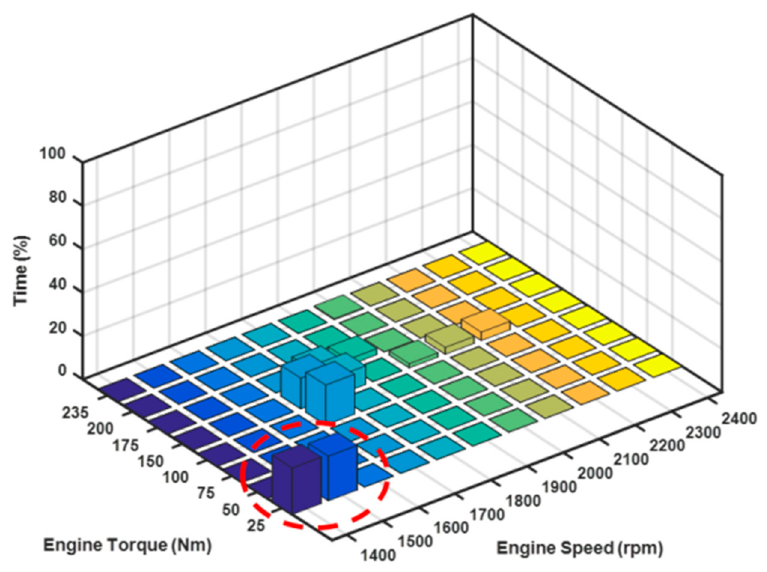
Figure 15. Engine operating time in urban driving cycle with baseline model.